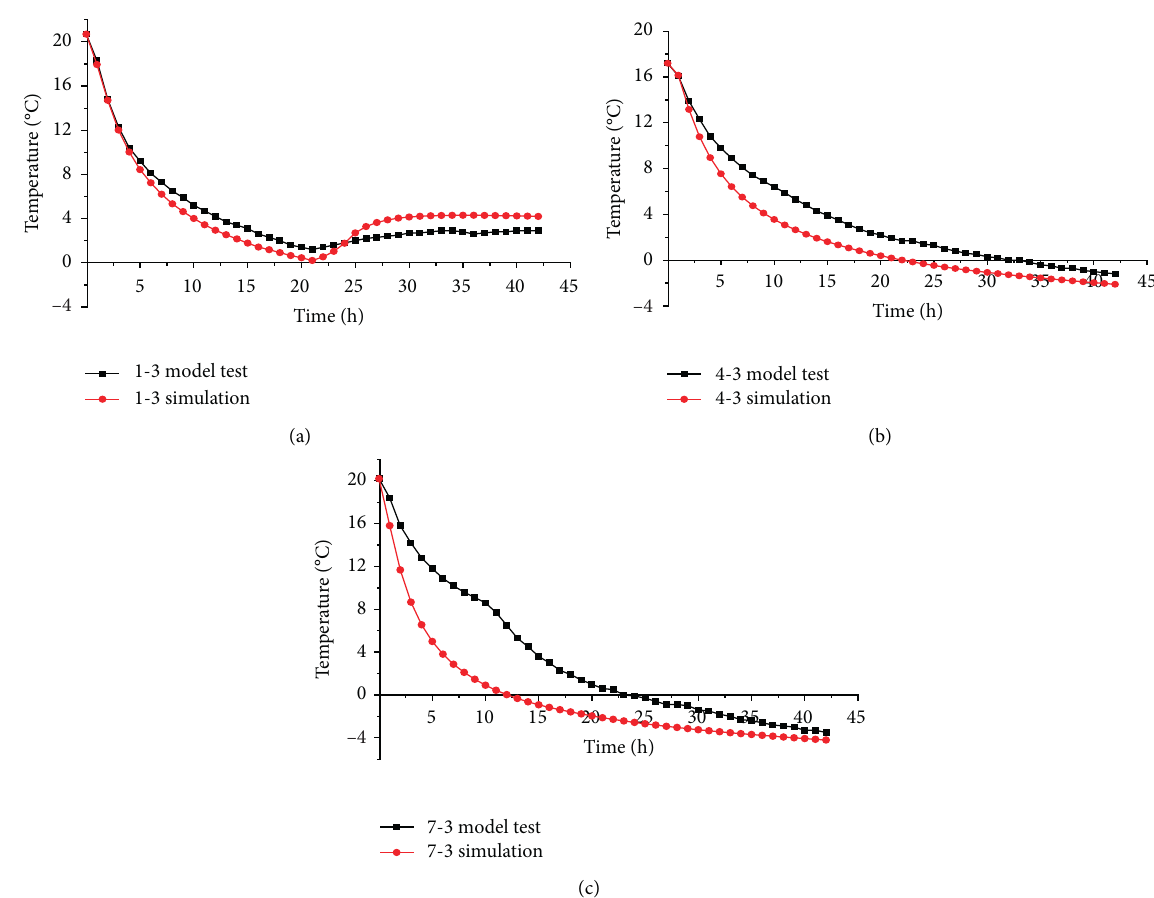
Figure 15: Temperature variation comparison diagram: (a) SCF; (b) EDCF; (c)